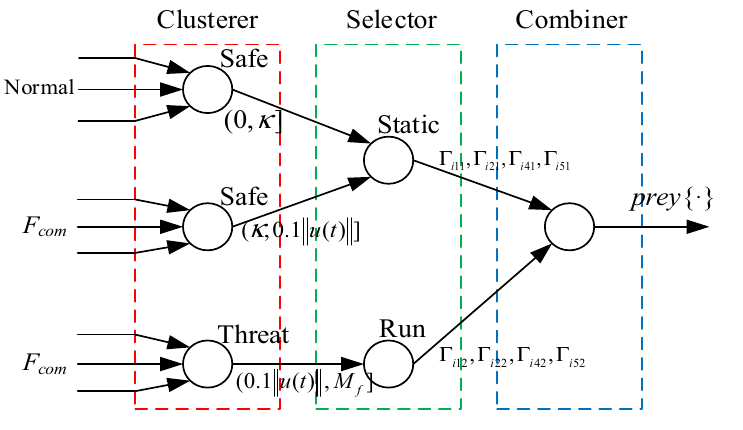
Figure 4. Strategic